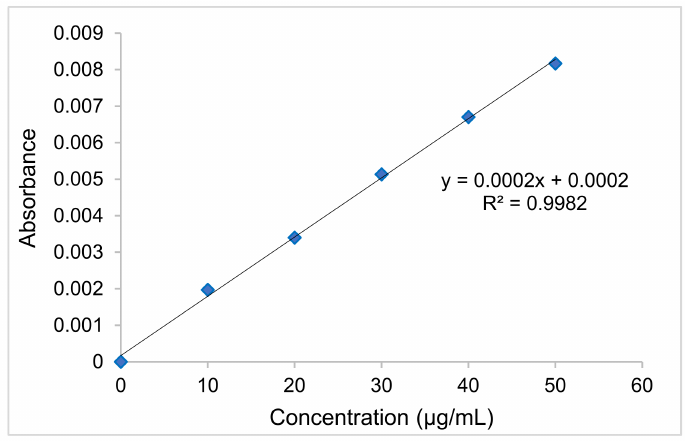
Figure 7. Standard calibration curve of diclofenac sodium (DS).